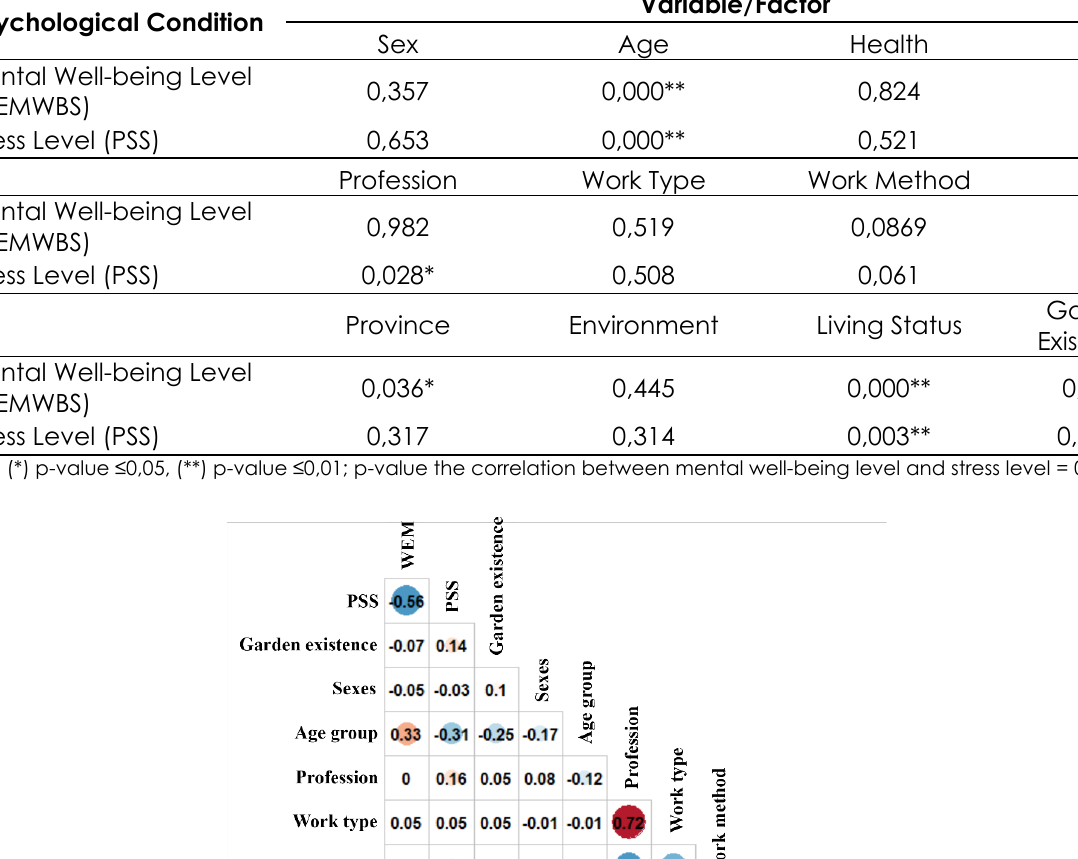
Habits that Have Connection with Psychological